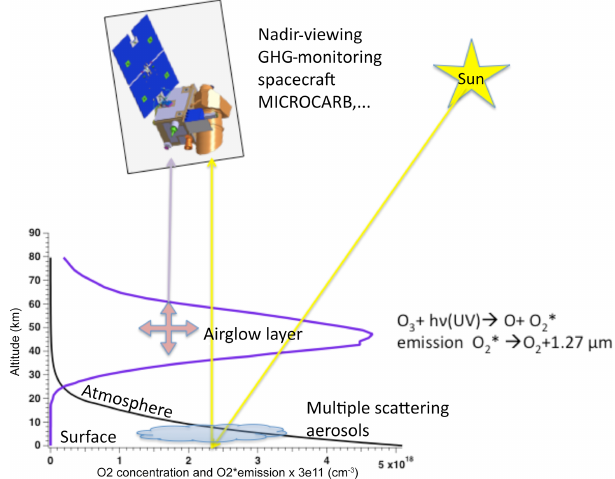
Figure 1. Sketch of a space instrument and platform to monitor greenhouse gases (GHGs), including CO 2 . The O 2 concentration (black curve) and the O 2 ∗ volume emission rate of the 1.27µm air- glow (blue curve) are plotted as a function of altitude. The optical path of nadir-viewing observations is inevitably crossing the air- glow layer, whose emission is superimposed on the spectrum of so- lar radiation scattered by the surface–aerosols–atmosphere system. The O 2 absorption at 1.27µm is mainly produced in the lower at- mosphere, while the airglow is in the range of ∼ 30–70km altitude. Ozone photolysis indicated in the figure is the main source of O 2 airglow at 1.27µm but not the only